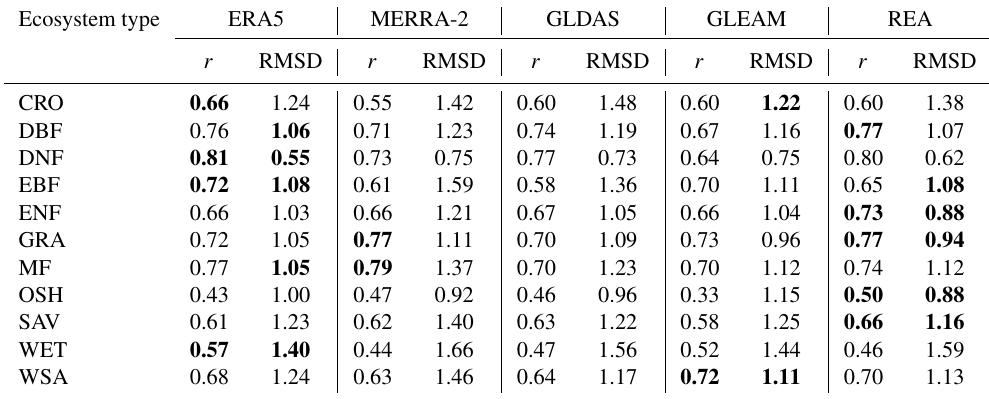
Table 2. The verification results including r and RMSD between daily ground-measured ET and daily ET from different products in different ecosystems. Values in bold indicate the highest